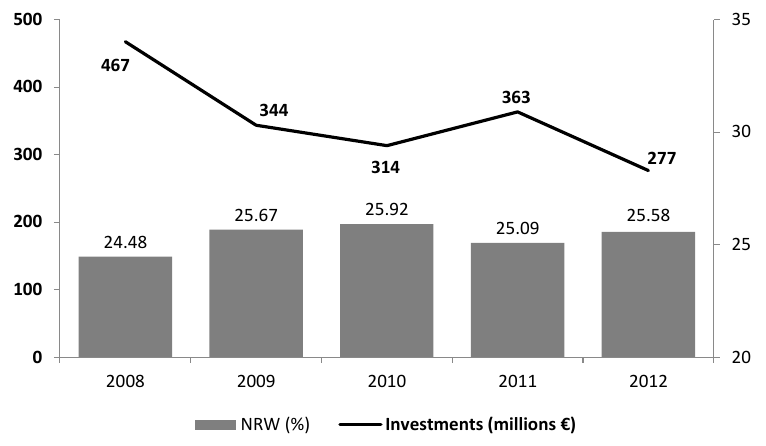
Figure 4. Relationship between urban supply services investments and non-revenue water in Spain (2008–2012). Source: Own elaboration from